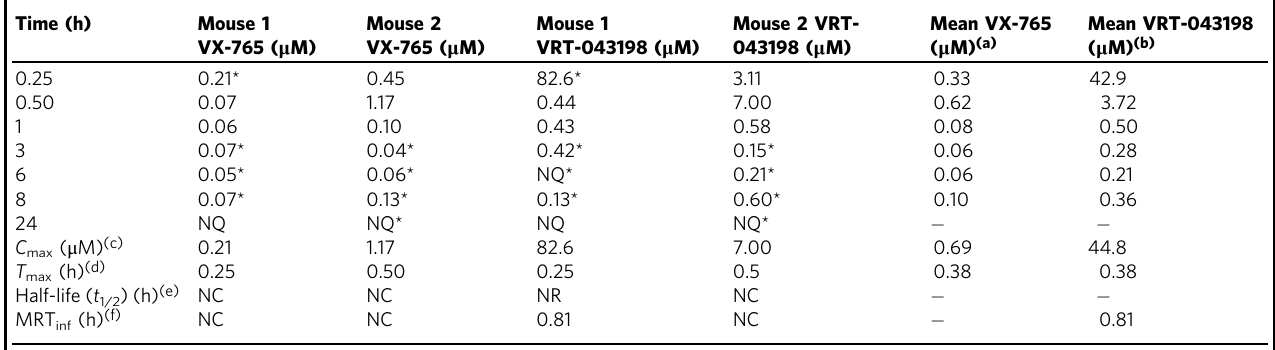
Table 3 VX-765 and VRT-043198 are detected in the CSF after a single IP dose of